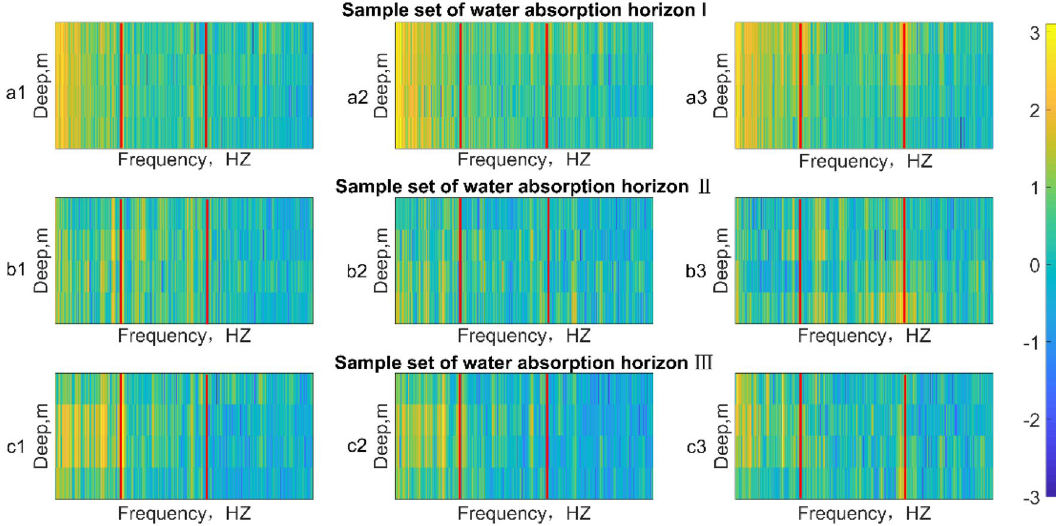
Fig. 8 Comparison of the identification results of different water absorption layer